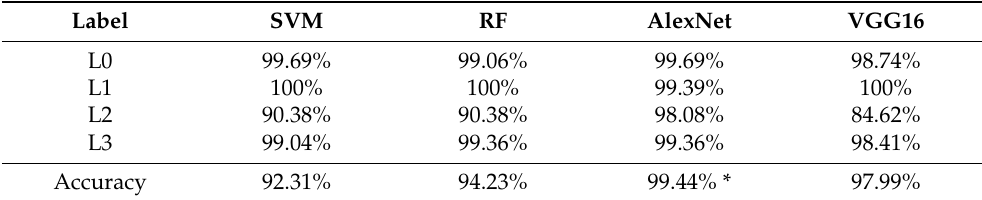
Table 5. Classification results of AlexNet, VGG16, SVM, and